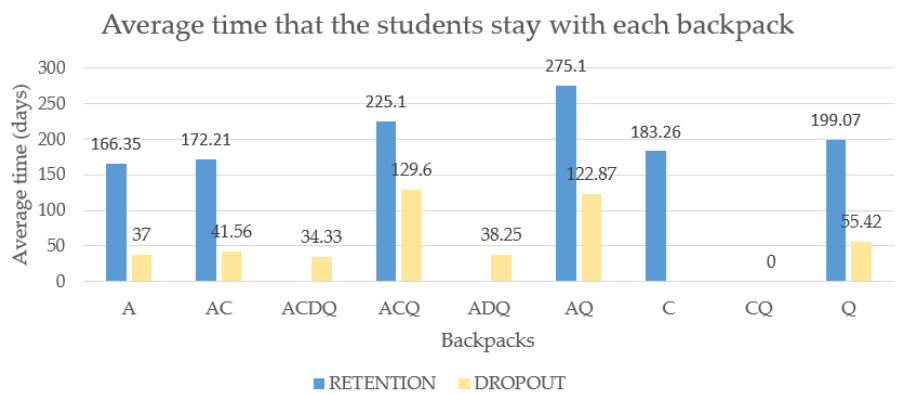
Figure 5. Average time (in days) that the students stay in each backpack. The graph considers only the most frequent variants for each model, corresponding to 80% of the students. The RETENTION columns consider only students who had a backpack and emptied it. The DROPOUT columns consider only students who had a backpack, were not able to empty it and finally dropped out.